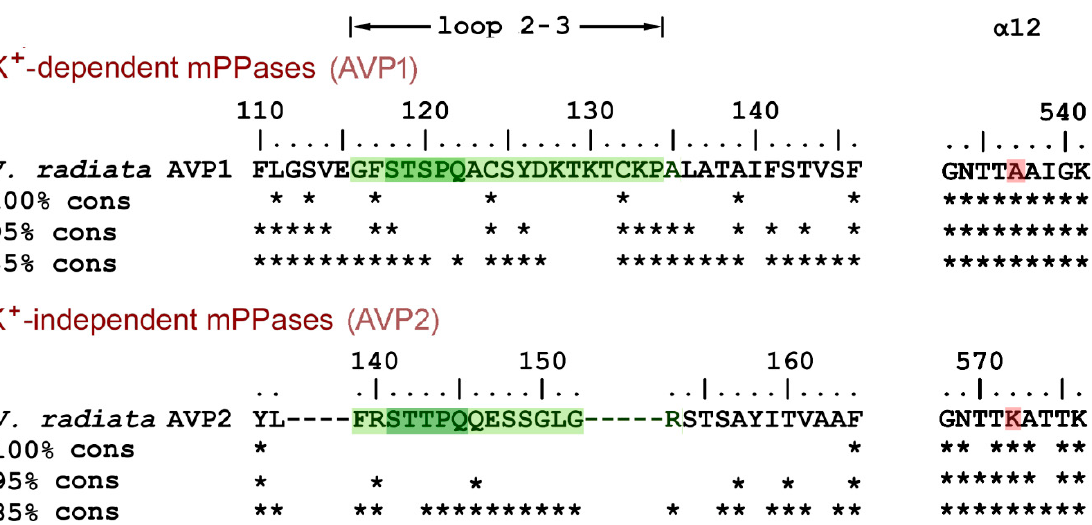
Figure 7. Alignment of loop 2–3 sequences in eukaryotic mPPases. The upper line on each part shows Vr-mPPase sequence, and the other lines indicate by asterisks the residues conserved in 100, 95, and 85% of the indicated mPPase subgroup sequences. Loop 2–3 sequences are highlighted in green. The gaps shown are found in all members of the AVP2 subgroup. Parts of the α 12 sequences shown on the right contain the K + dependence signature residue (highlighted in red).